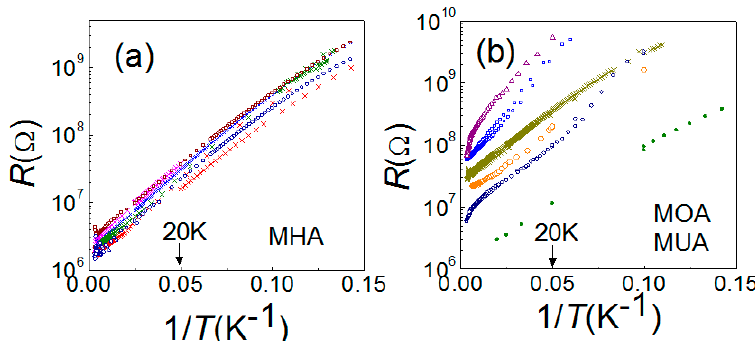
Figure 3. R vs. 1/ T plots for insulating MHA ( a ), MOA and MUA ( b ) devices. Each color represents individual device. At higher temperatures, the resistance follows the thermal activation property, namely, ln R ~ T − 1 . There is a slight deviation near room temperature, suggesting effect from thermal expansion.